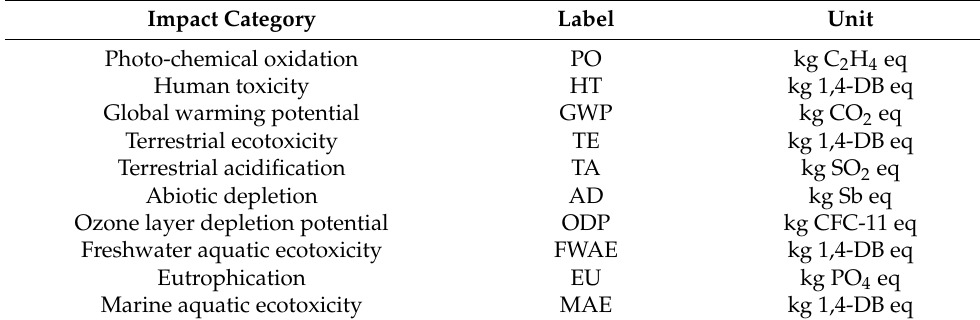
Table 2. CML 2 baseline 2000 impact categories.